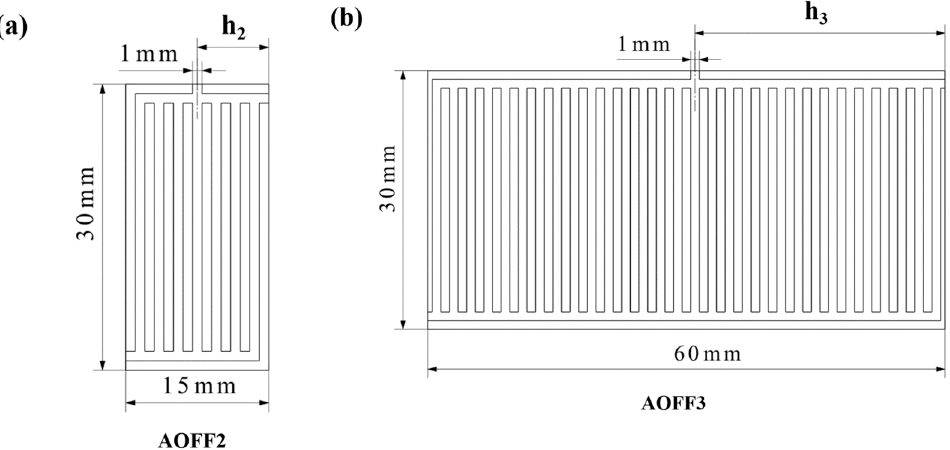
Figure 9. Schematics of ( a , b ) the additional outlet pattern at the flow field plate.